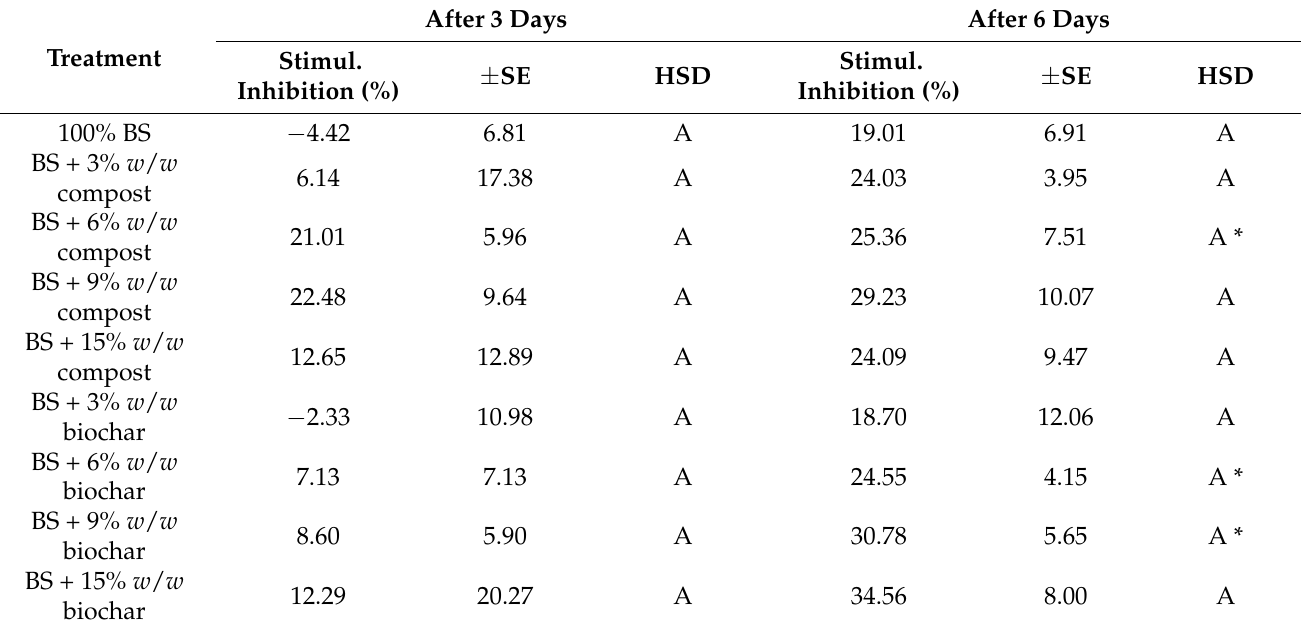
Table 6. Comparison of total average of stimulation/inhibition of root growth of Lepidium sativum L. after 3 and 6 days of exposure to burnt soil supplemented with compost in increasing proportions (compared to OECD